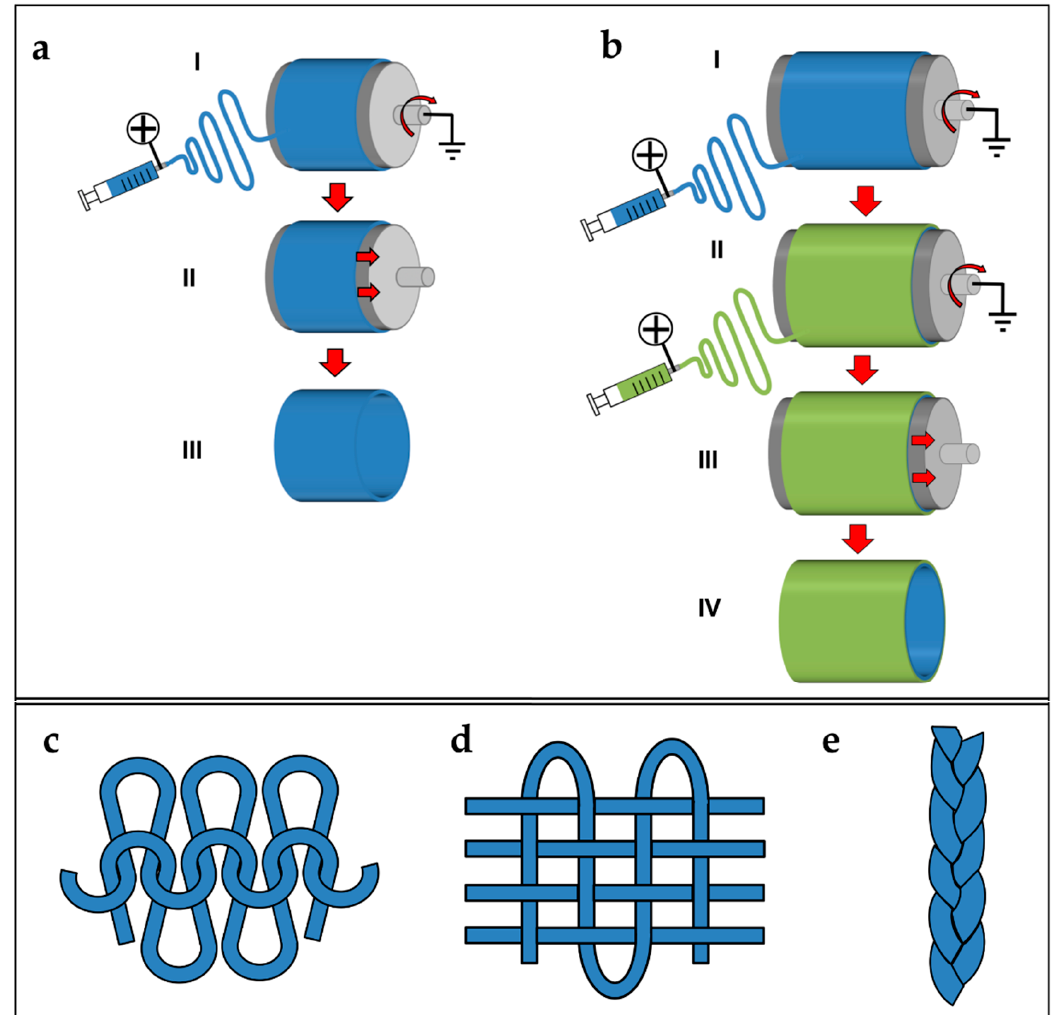
Figure 7. Different electrospinning setups and procedures to obtain tubes or conduits of nanofibers. ( a ) Tube of nanofibers obtained by a drum collector: (I) nanofibers are electrospun on a drum collector (by modulating the rotational speed, the nanofibers could be random or aligned); (II) the tube of nanofibers is removed from the drum; and (III) final tube of nanofibers. ( b ) Tube of different layers of nanofibers obtained by a drum collector: (I) the nanofibers of the first solution are electrospun on a drum collector (by modulating the rotational speed, the nanofibers could be random or aligned); (II) the nanofibers of the second solution are electrospun over the firs mat; (III) the mat of nanofibers is removed from the drum without cutting its side; and (IV) final tube of nanofibers with different nanofibers inside and outside. Different textile patterns to unit electrospun bundles or yarns of nanofibers: ( c ) Knitted; ( d ) Woven; and ( e ) Braided.